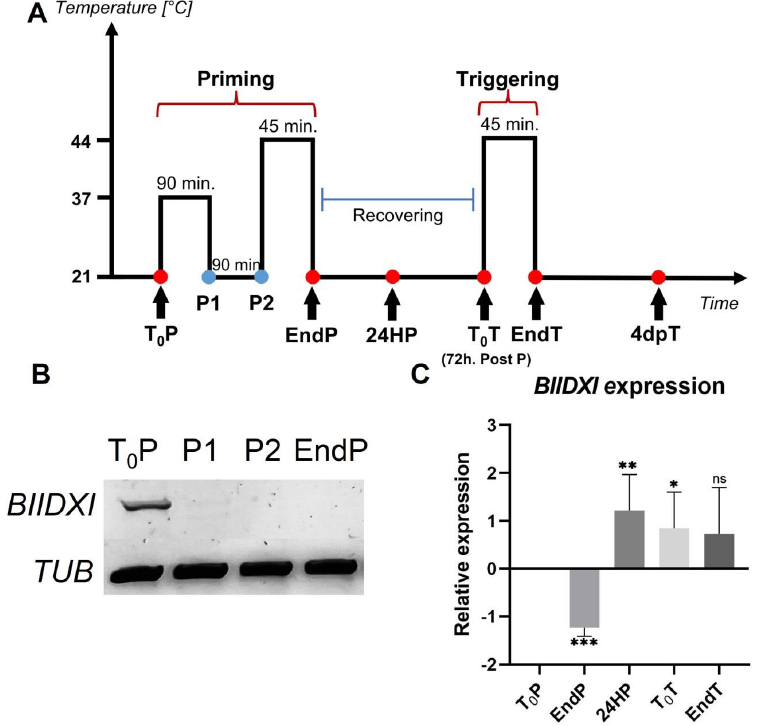
Figure 1. BIIDXI expression during thermotolerance and thermomemory. ( A ) Schematic represen- tation of the protocol (based on Olas et al. [29]). Seedlings were collected and frozen immediately at the beginning and at the end of priming (T 0 P and EndP), 24 h after the end of priming (24HP), 72 h after priming/start of triggering (T 0 T), at the end of triggering (EndT), and 4 days after triggering (4dpT). ( B ) BIIDXI expression within the priming, including sublethal heat treatment ( C ) on the BIIDXI expression level during triggering. The expression values are relative to T 0 P expression. Error bars indicate S.D. (n = 4). Statistical analyses were performed using Student’s t -test. Asterisks indicate statistically significant differences to T 0 P (* p < 0.05, ** p < 0.01, *** p < 0.001, ns, not